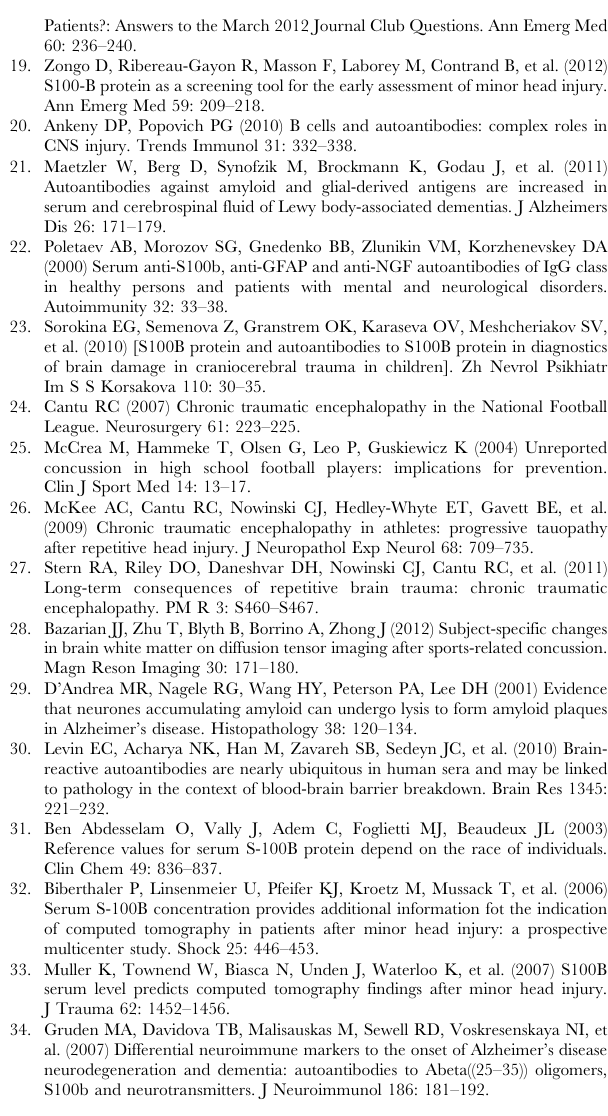
Figure S2 Validation of the auto-immune tests used to detect S100B autoantibodies. See also Methods. Table S1 Demographic characteristics of the players enrolled for the results in Figure S1. Table S2 Parameters of Head Hit Index (HHI) calcula- tions. A score system was used to segregate players based on the number and intensity of head hits experienced during games (see also Methods for details). Table S3 Reproducibility of reverse ELISA experiments used to measure antibodies against S100B in serum of athletes (n= 5 repeats). Commercially available human S100B was used to coat the wells; the standard used to transform absorbance in m g/ml consisted of human monoclonal anti-S100B antibodies. The mean absorbance and its variability (Standard Deviation values and its %) are shown. Data were obtained by calibrating the system with human monoclonal anti-S100B